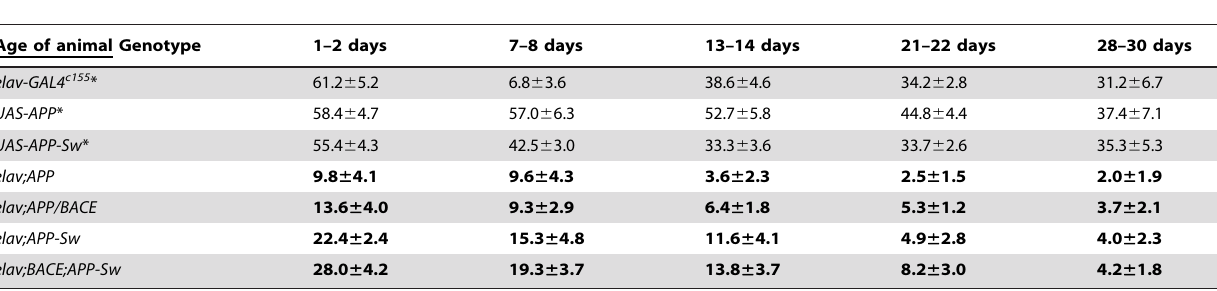
Table 1. Progressive loss of learning ability in APP -transgenic flies.